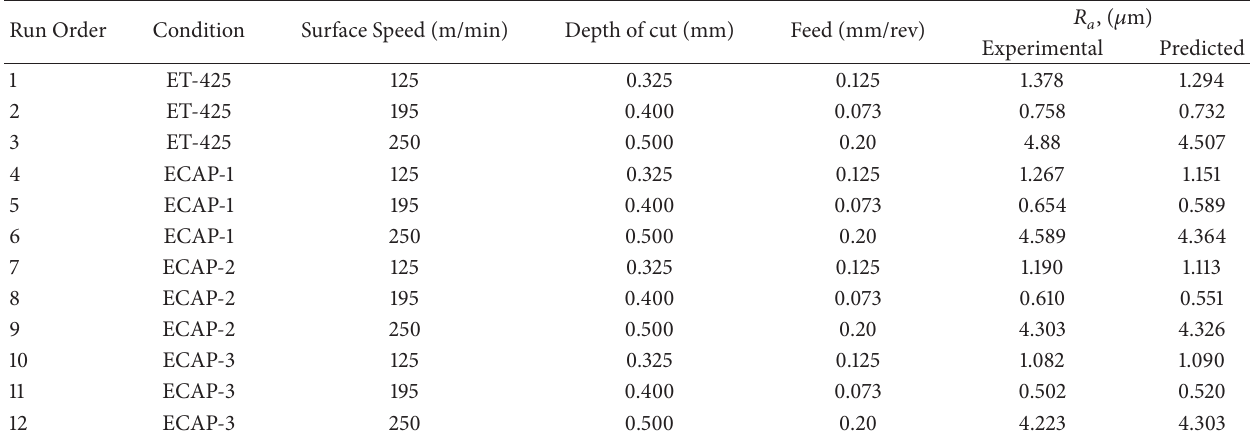
Table 6: Extra runs for valediction and verification of the predicted equations in Table